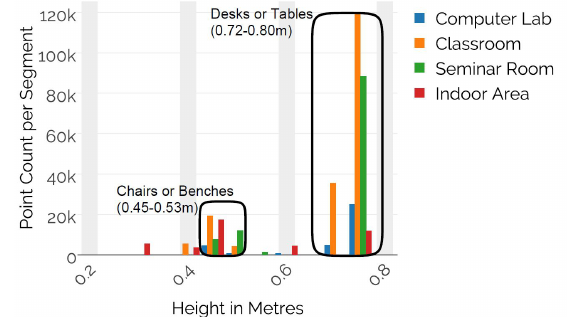
Figure 5: Histogram of height clusters per scene for the horizon- tal segments. These were weighted by point count per segment.